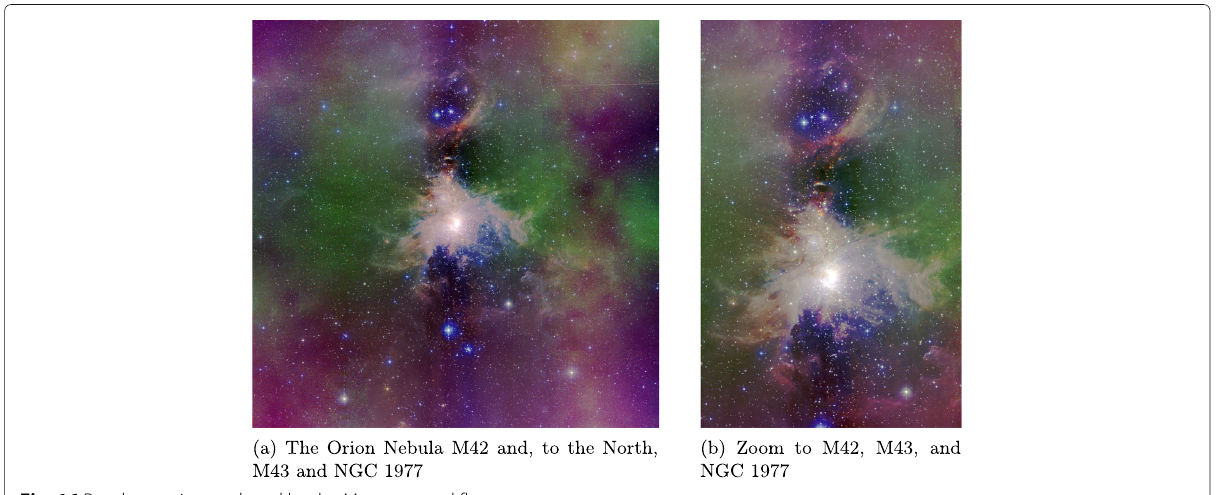
Fig. 16 Result mosaics produced by the Montage workflow